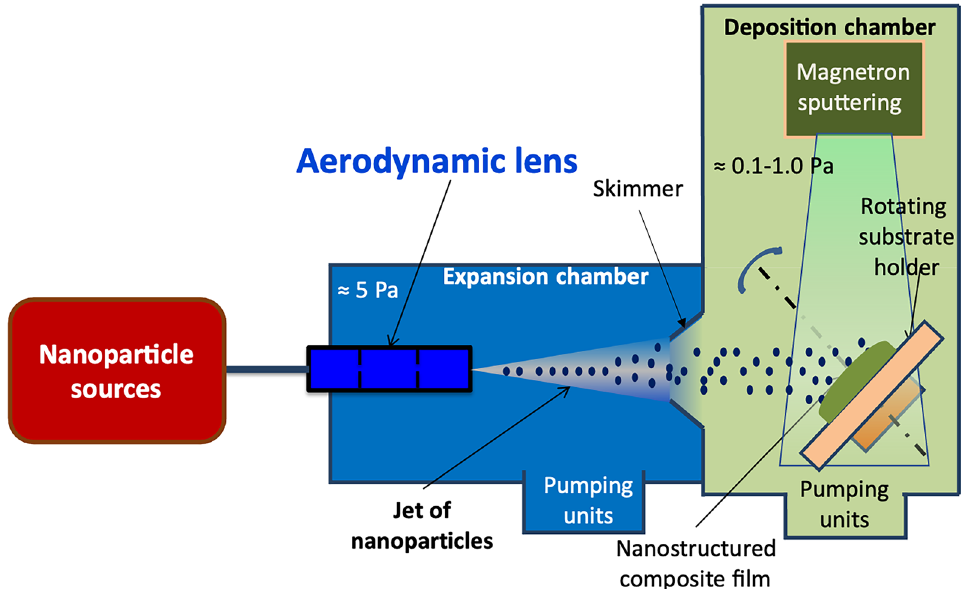
Figure 2. Scheme of the nanocomposite thin film process constituted by a source of nanoparticles connected to an expansion chamber equipped with an aerodynamic lens allowing the transfer of the nanoparticles to the sputtering